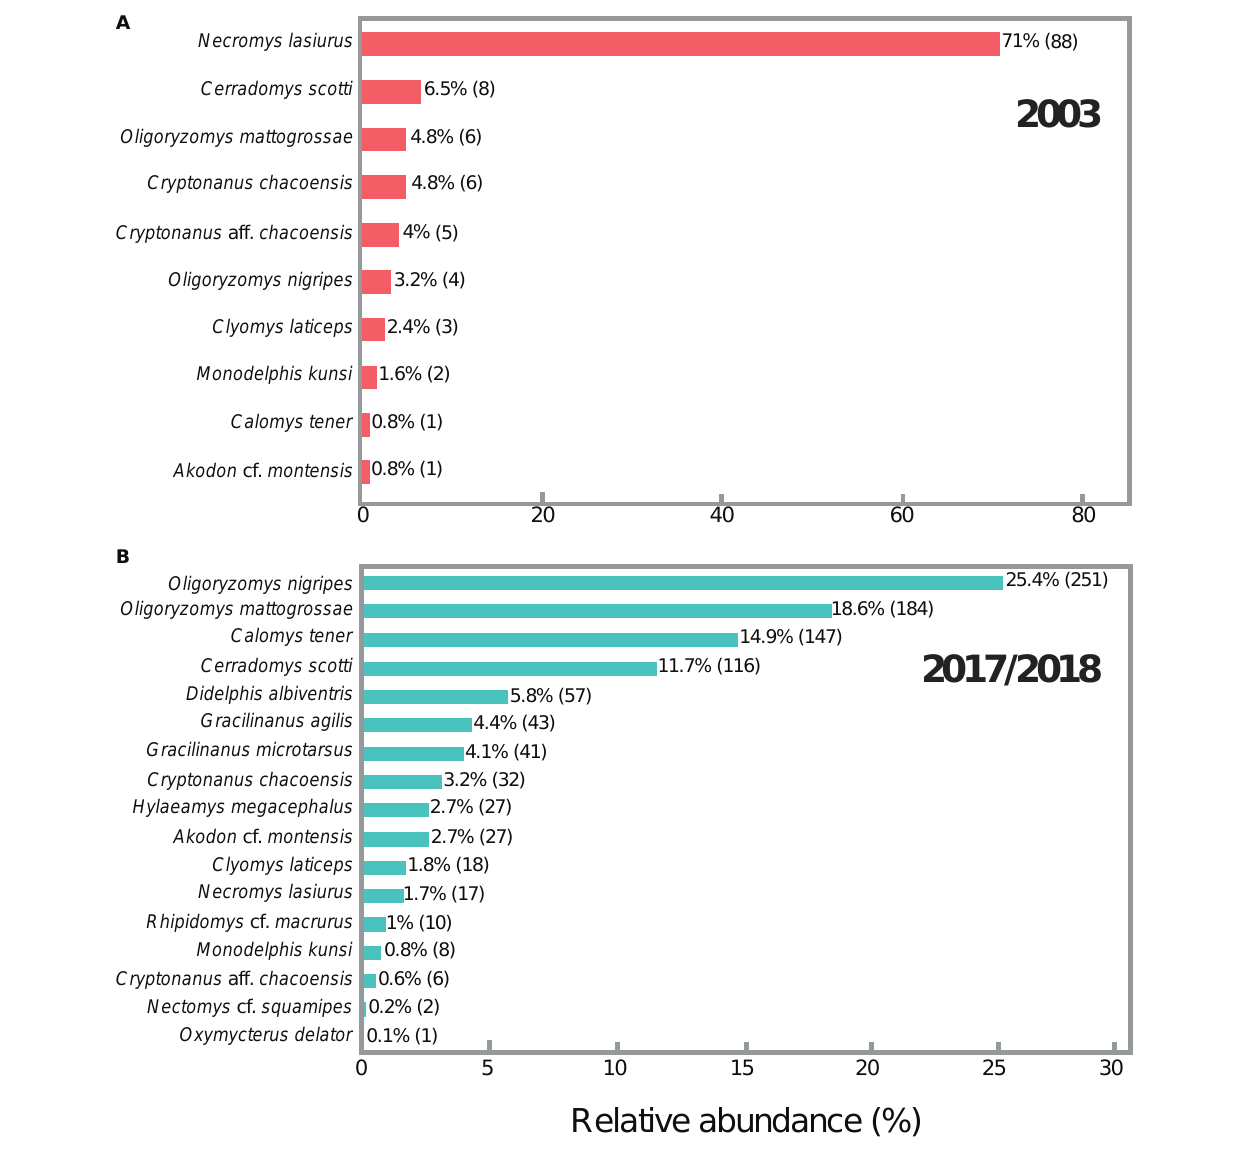
p = 0.02). This result indicates an increase in vegetation density of 27.4% in 15 years, affecting primarily the open areas ( Figures 4 , 5A ). The linear model for EVI regarding the habitat types demonstrated a clear difference in its EVI mean values ( R 2 adj. = 0.62, F 4 , 11 = 7.1, p = 0.004, Figure 5B ), with the open habitats (“ campo limpo ,” “ campo sujo, ” and “ campo cerrado ”) not different considering their EVI mean values, despite following a gradual increase on averages (0.30, 0.36, and 0.41,